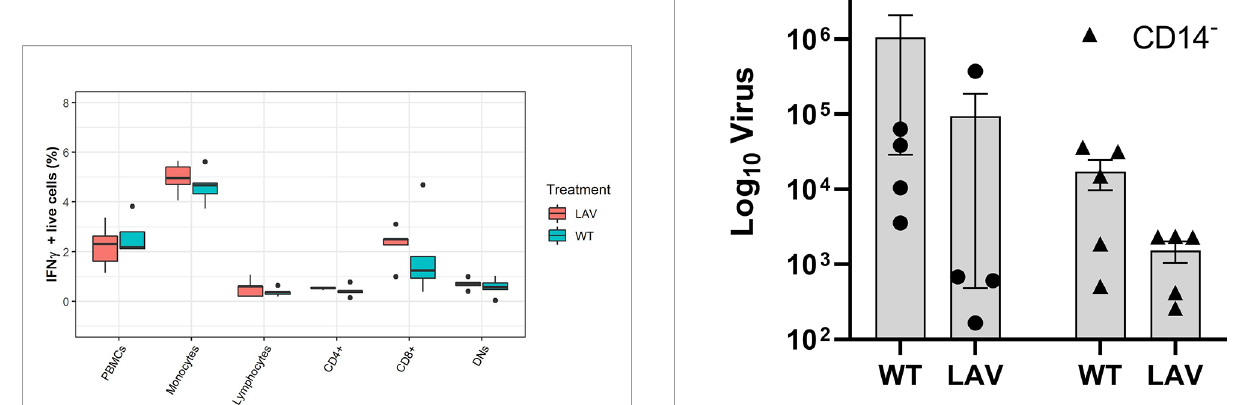
FIGURE 4 | Flow cytometry analysis of the expression of IFN g in PBMC subpopulations. The box plots represent the percentage of IFN g expression in healthy sheep PBMC sub-population infected with either WT SPPV or LAV SPPV.